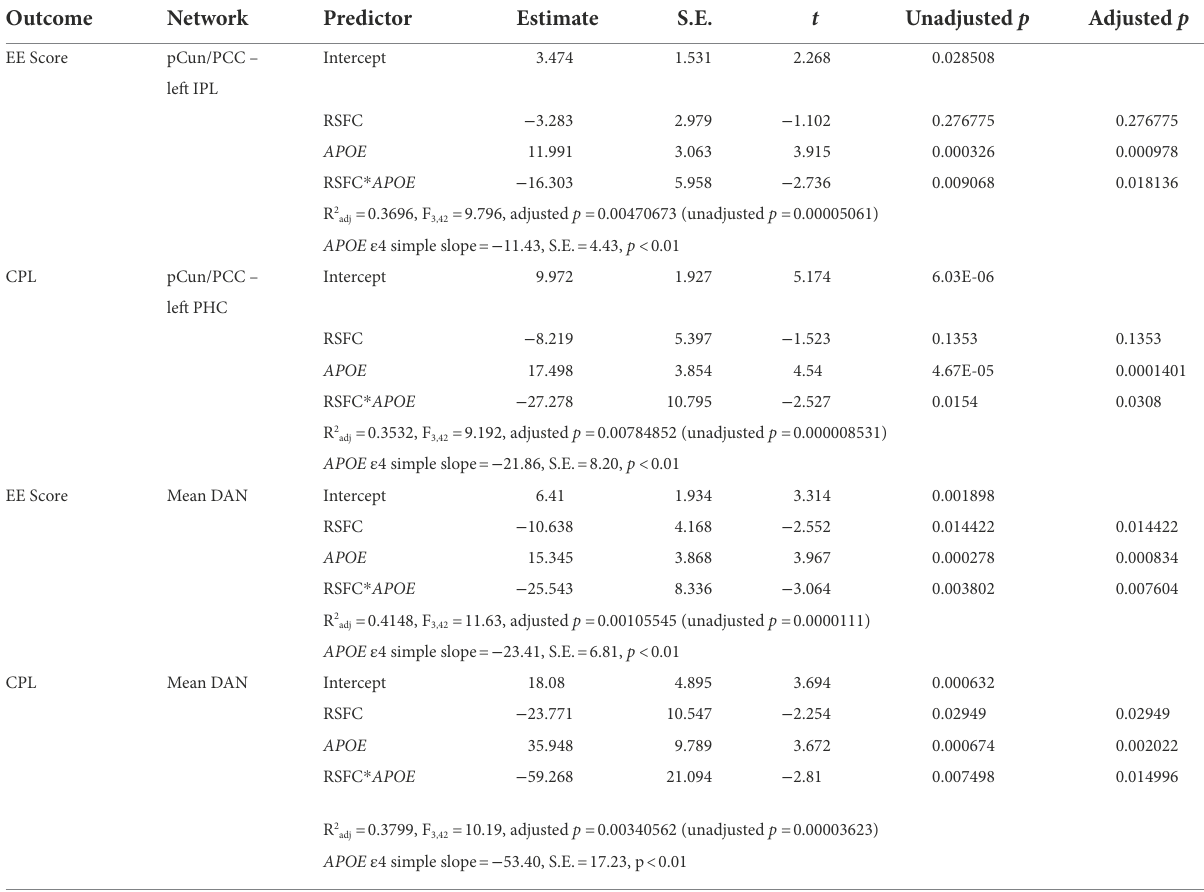
TABLE 2 Multiple linear regression models used to assess whether non-standard visuomotor performance declines are associated with resting state functional connectivity (RSFC).